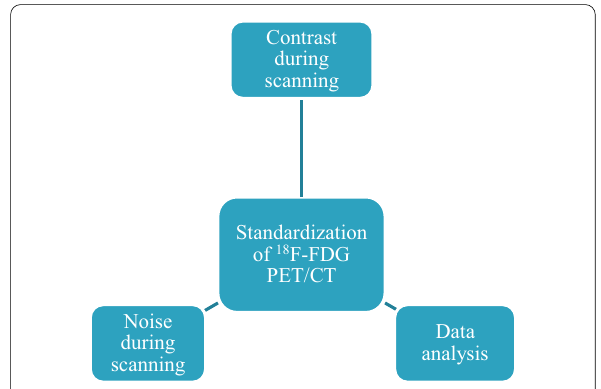
Fig. 8 Factors impacting 18 F-FDG PET/CT feature